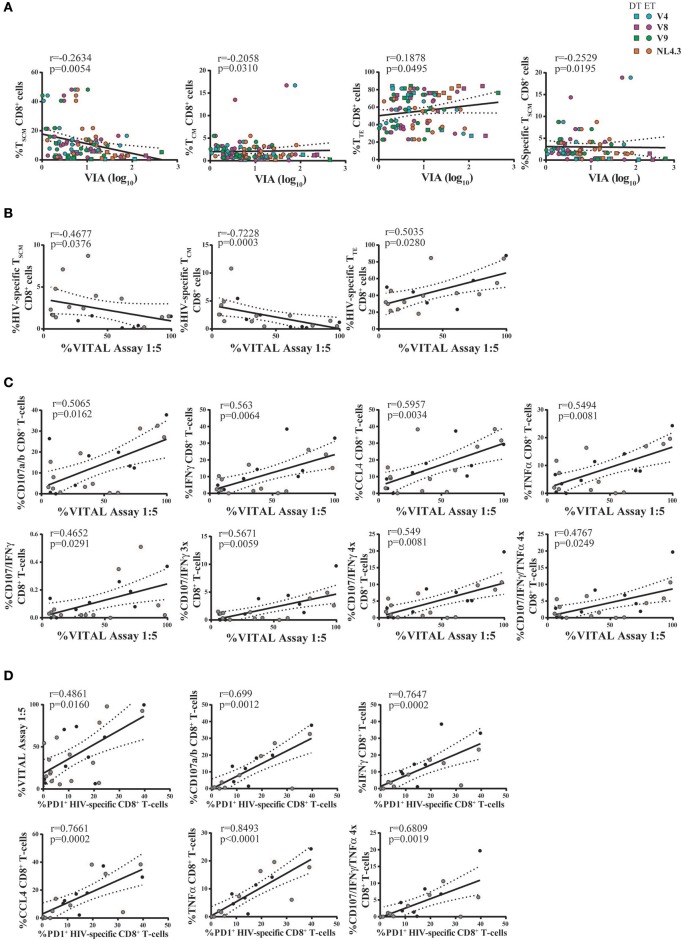
Correlation analyses between antiviral activity versus cell phenotype and functionality of expanded CD8+ T-cells. (A) Correlations between VIA magnitude (evaluated against all viruses and merging data from Nef-specific and p24-specific effectors) and bulk and HIV-specific CD8+ T-cell memory phenotype. Square dots represent DT subjects and round dots represent ET subjects. The different viral strains employed in the VIA experiment are displayed in a different color, matching the color code showed in Figure 6A. (B,C) Correlations between VITAL magnitude and the proportions of HIV-specific CD8+ T-cell memory phenotype (B), and the proportions of CD8+ T-cell functionality (C). (D) Correlations between the percentage of PD-1 expressing HIV-specific CD8+ T-cells and cell functionality. (B–D) Black dots represent DT subjects and gray dots represent ET subjects. r and p values correspond to Spearman's correlations.